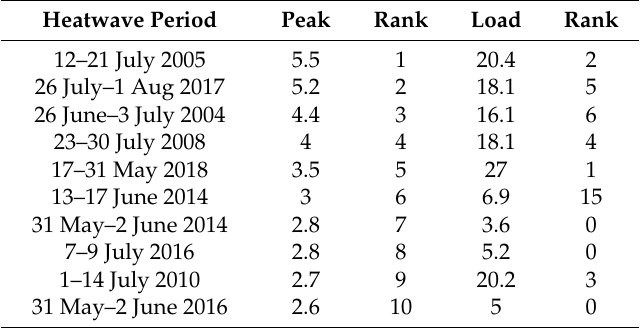
Table 9. Heatwave event peak and load using severity for Guangzhou (1945 to 2018). Top 10 ranked for event peak severity. Severity is dimensionless [].